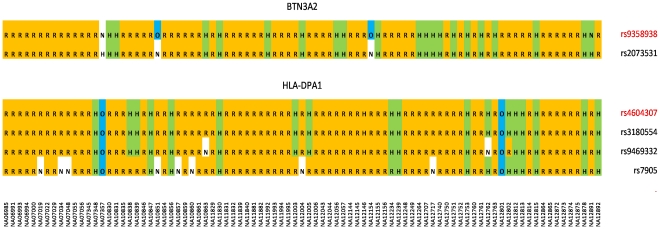
The illustration of the identity and association between SNPs in miRNA target sites and the documented SNP markers.In each panel (corresponding to a gene), the first row indicates the cis-associated SNP for the exon-level transcript level (a ratio) identified in [13], and the other rows each indicates a SNP related to a target site of an expressed miRNA in the EBV transformed lymphoblastoid cell lines. The letters in the shaded cells represented the recoded genotypes using the proposed method in this paper. R (highlighted in yellow) represents a (single-based) homozygous genotype with the two reference alleles as in hg18. H (highlighted in green) represents a heterozygous genotype with one reference allele and one alterative allele. O (highlighted in blue) represents a homozygous genotype with the two alternative alleles, and N (not shaded) represents an unknown genotype.